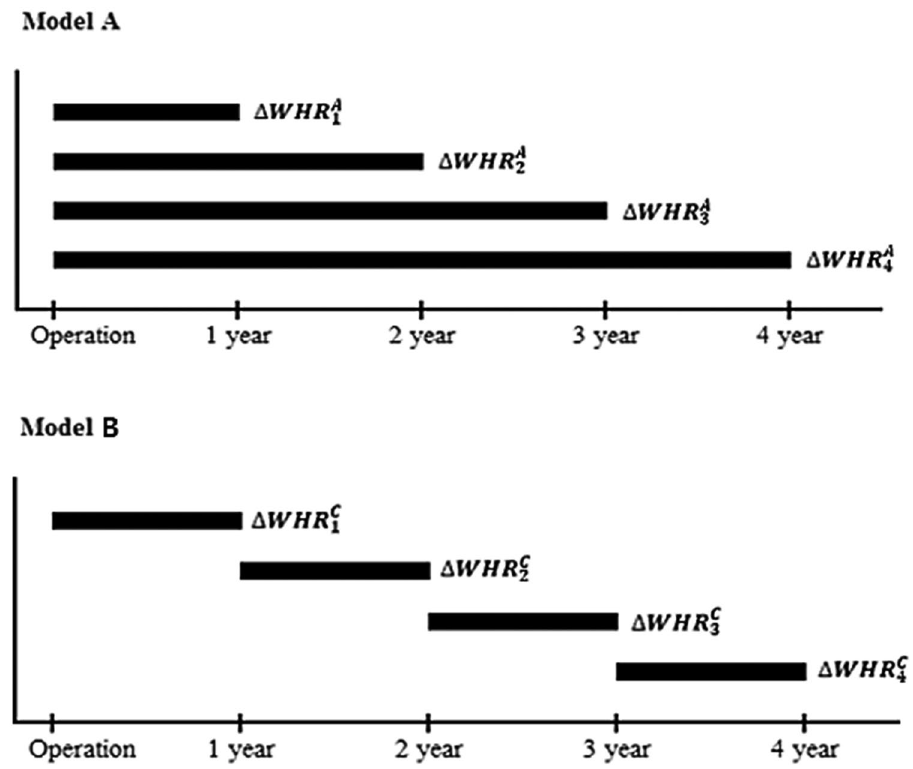
Figure 1. Changes in waist-to-hip ratio (WHR) every year up to n-years after kidney transplantation in patients with a cardiovascular event. The effect of WHR changes on the event occurrence was assessed. Models of patients with events up to 4 years after kidney transplantation are